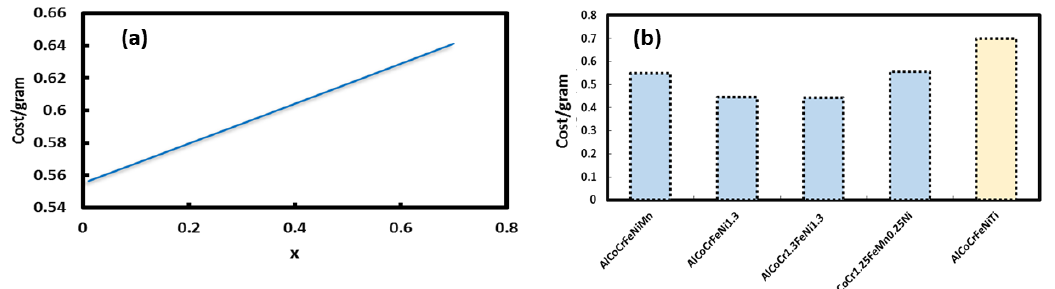
Figure A9. ( a ) Cost/gram for CoCr 1.3 FeMn 1+x Ni 0.7−x alloy system for different values of ‘x’. It can be seen that cost increases linearly with respect to ‘x’. ( b ) Estimated cost/gram of shortlisted HEAs to be used for additive manufacturing.